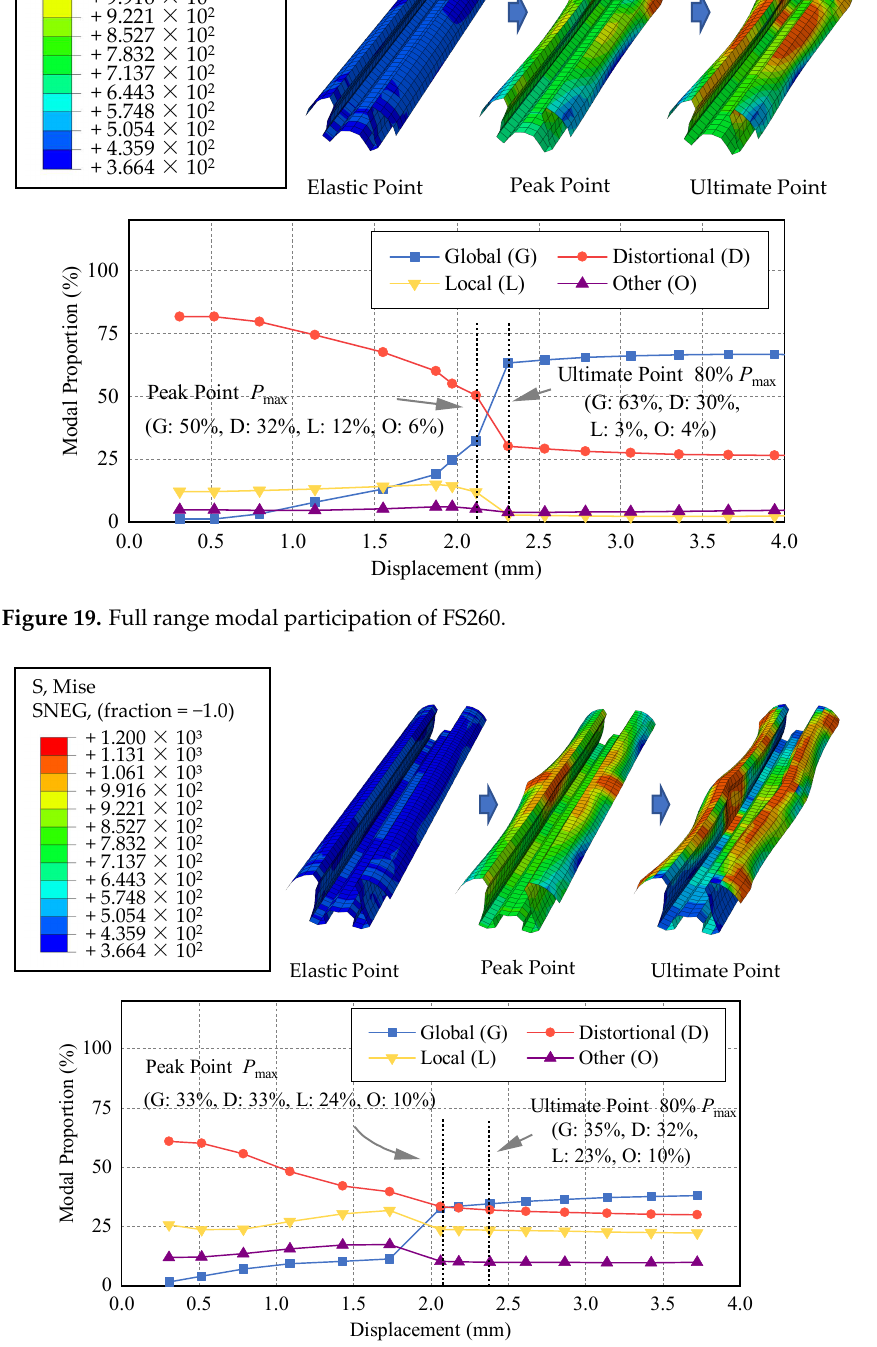
Figure 20. Full range modal participation of FS300.